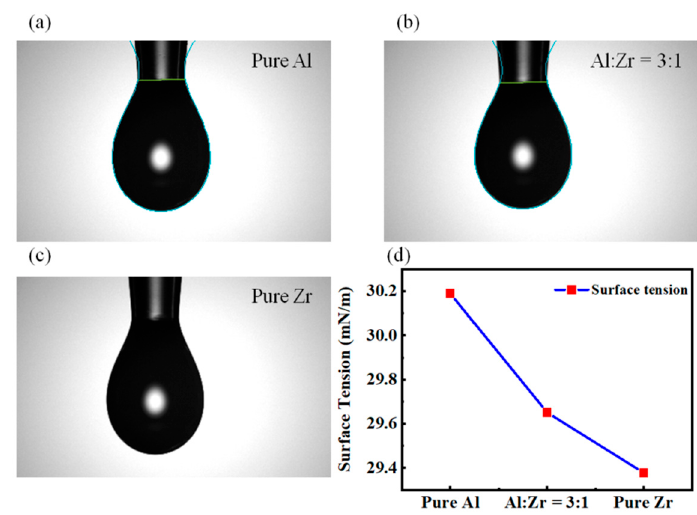
Figure 1. Dropping images. ( a ) Pure aluminum solution; ( b ) mixed zirconia and alumina solution (1:3); ( c ) pure zirconium nitrate solution; ( d ) surface tension of these solutions.